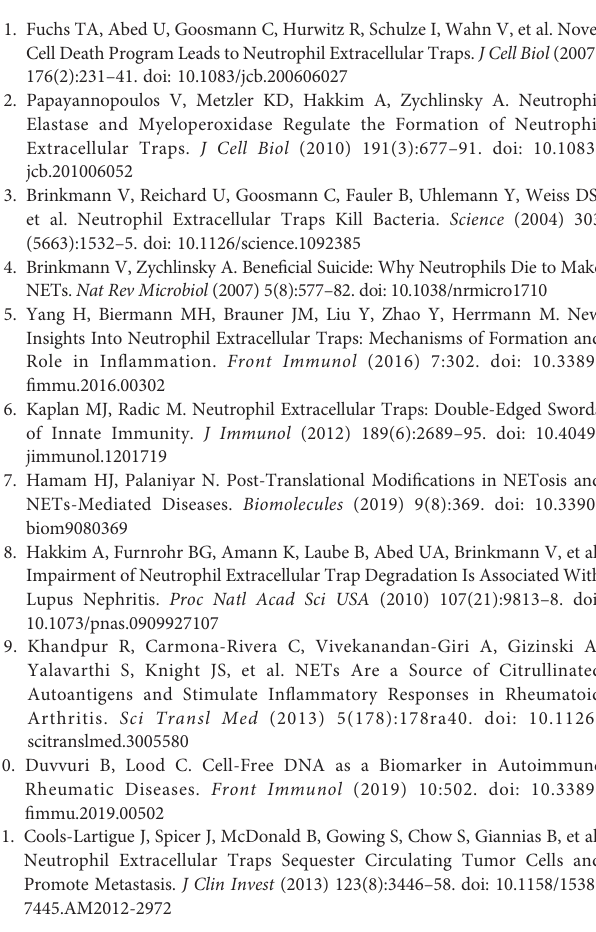
Supplementary Figure 1 | Representative FACS dot plots for survivaland histogramsfor activationafter treatmentwithG-CSF.Neutrophils wereincubated with severalamountsofG-CSFormediumonlyandanalysedafter6h (A) ,24h (B) ,48h (C) and72h (D) incubationbystainingwithAnnexin-VandPI.Doublenegativecells(green) are considered vital, Annexin-V pos (orange) are considered inapoptosisand double positivecells(red)areconsidereddead.ExpressionofCD11bandCD66bwasanalysed byFACS analysis after incubation of neutrophilgranulocytes with G-CSF ormedium onlyfor6h (A) ,24h (B) ,48h (C) and72h (D) .Everydotplotorhistogramconsistsof Supplementary Figure 2 | Representative FACS dot plots for survival and histograms for activation after LPS treatment. Neutrophils were incubated with several amounts of LPS or medium only and analysed after 6 h (A) , 24 h (B) , 48 h (C) and 72 h (D) incubation by staining with Annexin-Vand PI. Double negative cells (green) are considered vital, Annexin-V pos (orange) are considered in apoptosis and double positive cells (red) are considered dead. Expression of CD11b and CD66b was analysedbyFACSanalysis afterincubation ofneutrophilgranulocytes withLPS